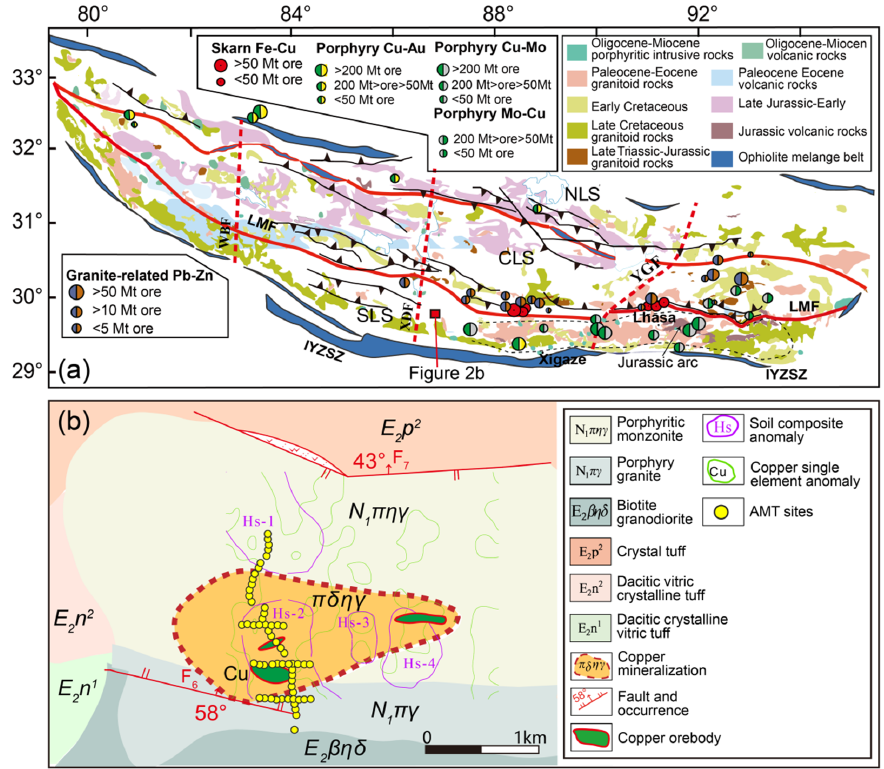
Figure 2. ( a ) Simplified geologic map of the Gangdese metallogenic belt, showing the distribution of Late Triassic to Miocene magmatic rocks and ore deposits in the belt (modified from [7]); ( b ) Geological map of the Cimabanshuo porphyry copper deposit and the locations of AMT sites (modified from [23,25]). Abbreviations: CLS = central Lhasa subterrane, IYZSZ = Indus-Yarlung–Tsangpo suture zone, LMF = Luobadui–Milashan fault, NLS = northern Lhasa subterrane, SLS = southern Lhasa subterrane, WBF = Wenbu Fault, XDF = Xuru-Dangreyong Fault, YGF = Yadong-Gulu Fault.